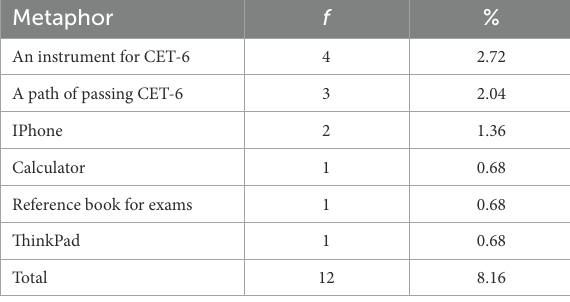
TABLE 5 Frequency and percentage of the textbook metaphor in the conceptual category of “exam-orientated.” Metaphor f %